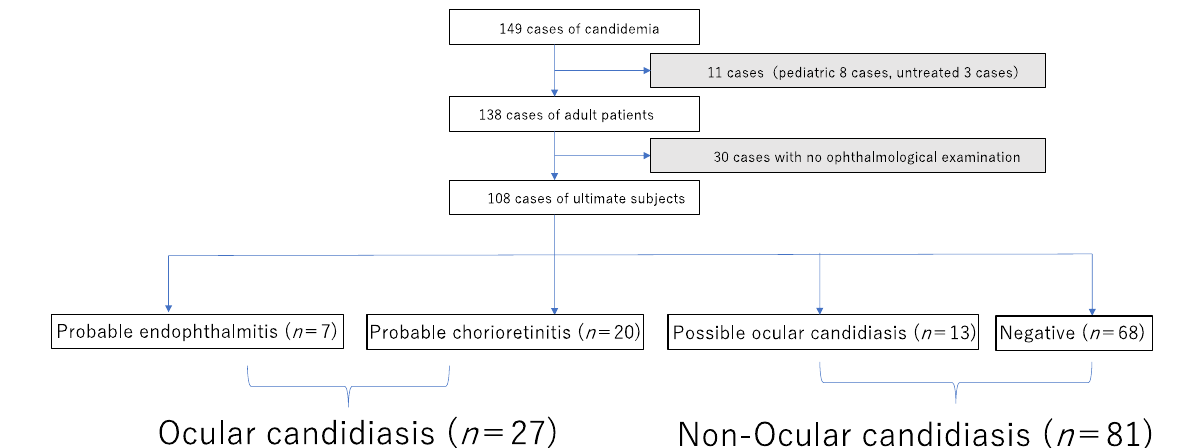
Figure 1. The process of selecting and classification target cases. Gray shadow: excluded cases. The ultimate analysis included 108 cases. Twenty-seven cases of ocular candidiasis included seven proba- ble endophthalmitis and twenty probable chorioretinitis. Eighty-one cases of non-ocular candidiasis included thirteen possible ocular candidiasis and sixty-eight cases with no sign of ocular candid- iasis.